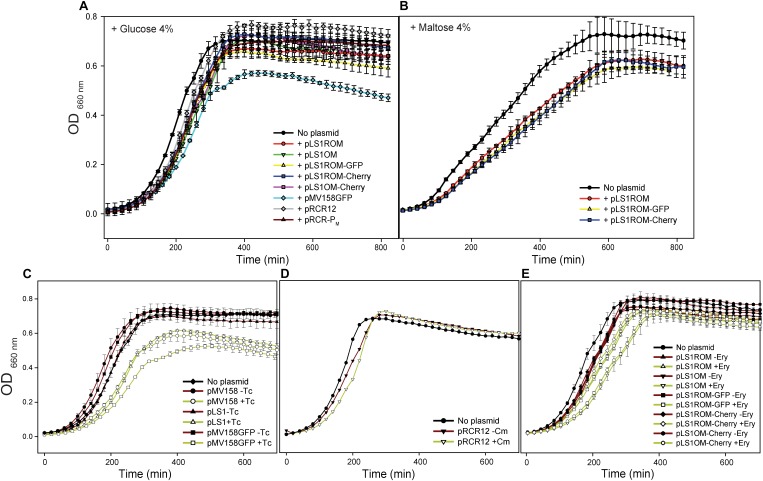
Effect of the presence of the plasmid vectors on the bacterial host fitness. Strains of L. lactis MG1363 lacking any plasmid or harboring the indicated plasmids were grown in M17 supplemented with glucose (A) or maltose (B), and in the presence of selective pressure for the antibiotic resistant marker codified by the resident plasmid. In addition, L. lactis strains carrying pMV158, pLS1, pMV158GFP (C), pRCR12 (D), or a plasmid of the pLS1ROM/OM series (E) were grown in M17G in the presence (+) or in the absence (−) of selective pressure. Optical density at 660 nm was measured every 20 min using a Varioskan microplate reader. Plots display representative growth curves of each strain as obtained from one of at least three independent experiments (biological samples), with the symbols and vertical bars representing the average and errors of three technical triplicates.